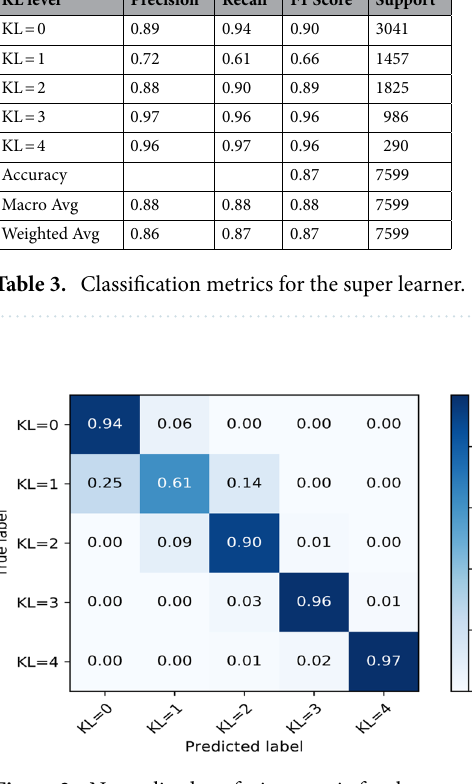
Figure 3. Normalized confusion matrix for the super learner model.